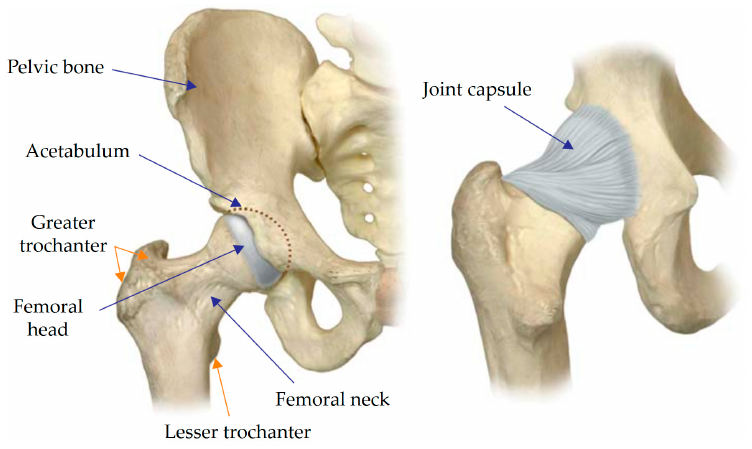
Figure 1. Anatomy of the hip joint [1].